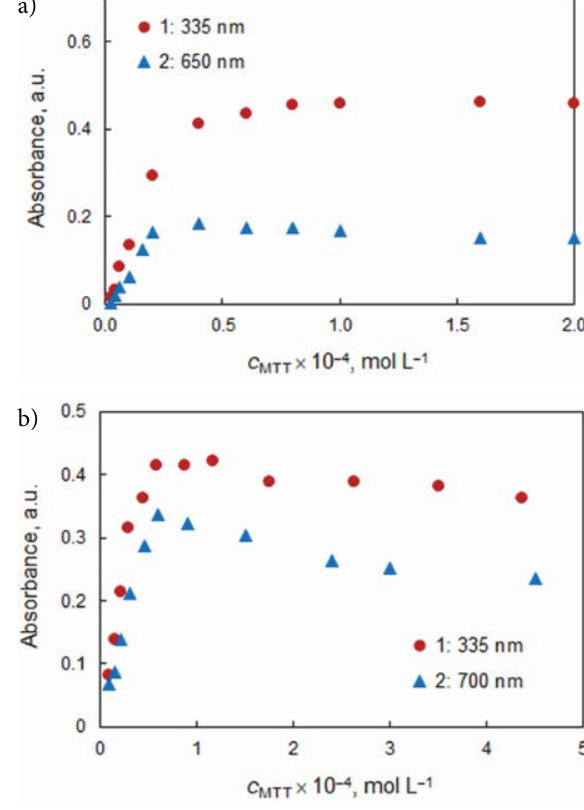
Figure 4. Absorbance of extracted complexes of V V (a) and V IV (b) vs MTT concentration. a ) c V(V) = 3 × 10 −5 mol dm −3 , c DN = 6.0 × 10 −4 mol dm −3 , pH 5.5, λ = 335 nm (1) and 650 nm (2). b ) c V(IV) = 2 × 10 −5 mol dm −3 (1) or 3 × 10 −5 mol dm −3 (2); c DN = 4.0 × 10 −4